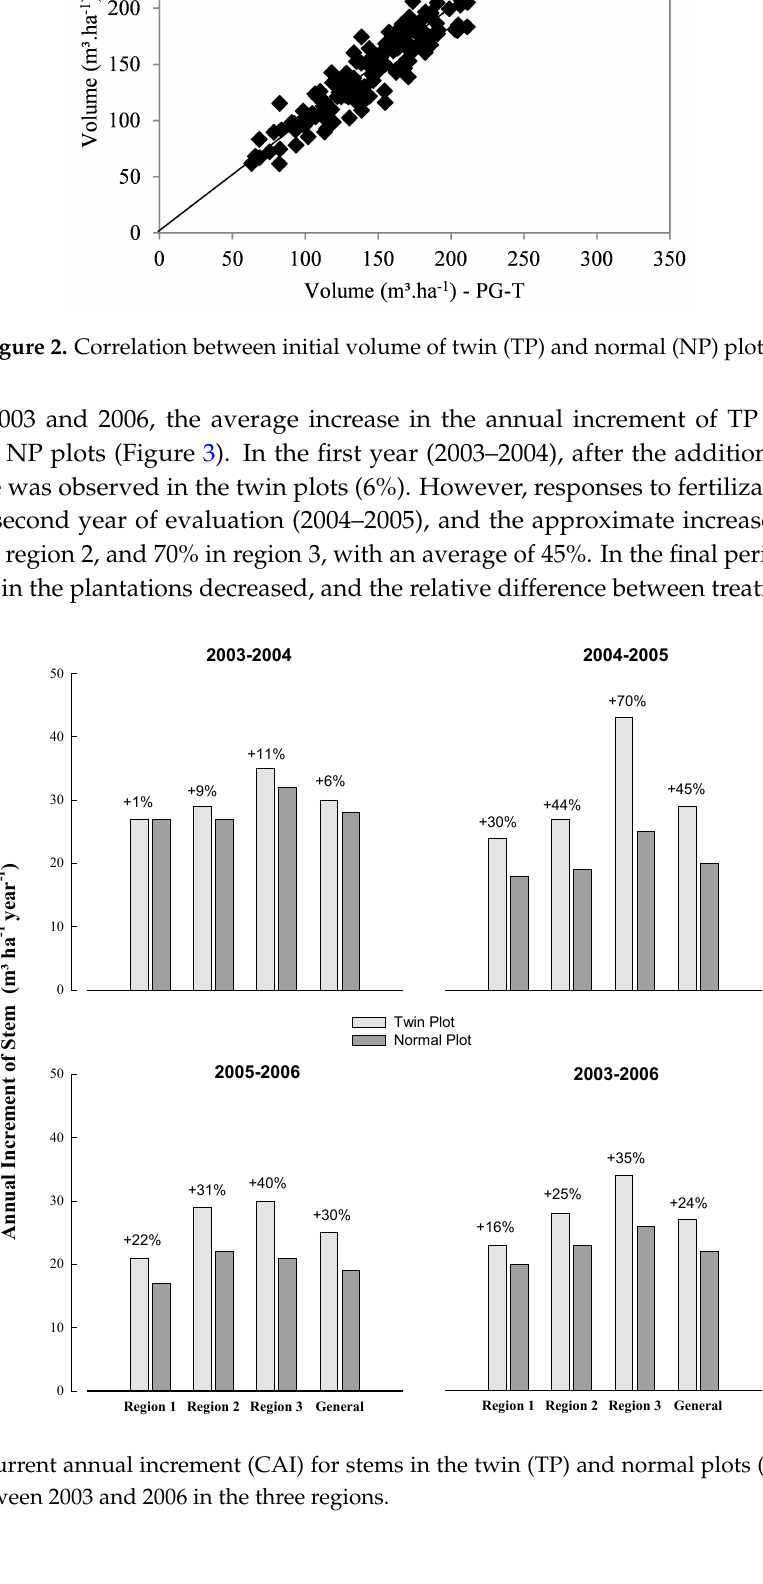
Figure 3. Current annual increment (CAI) for stems in the twin (TP) and normal plots (NP) for the periods between 2003 and 2006 in the three regions.